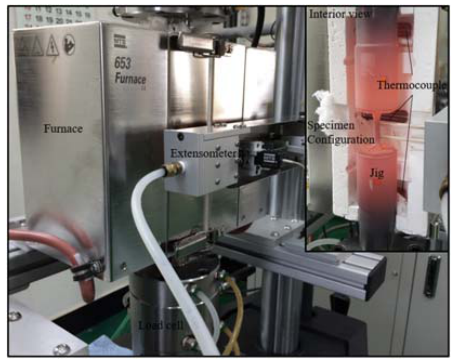
Figure 3. Apparatus and experimental setup of the LCF test.